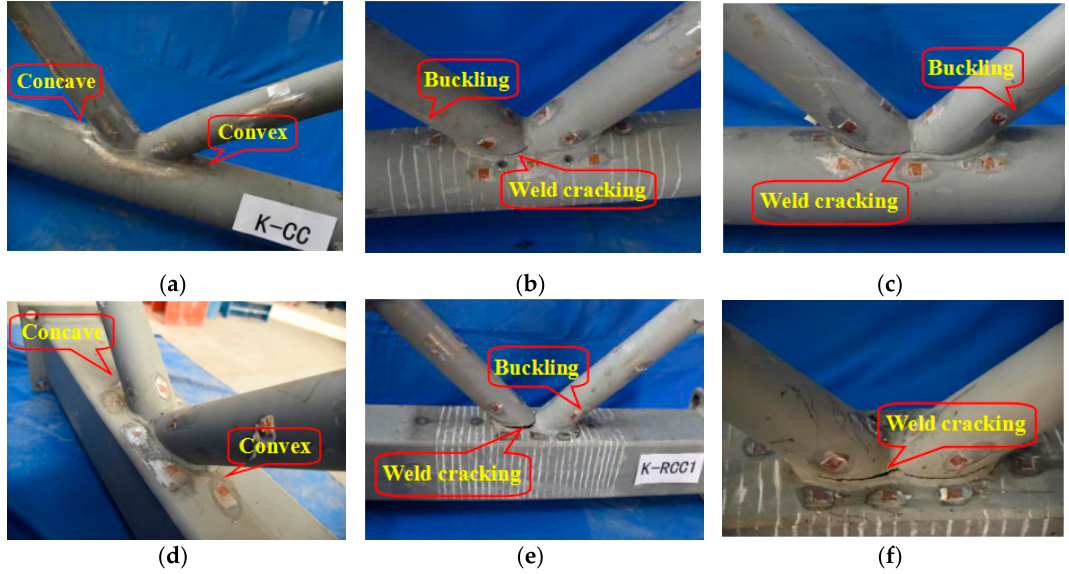
Figure 6. Failure characteristics of the joints. ( a ) K-CC; ( b ) K-CCC1; ( c ) K-CCC2; ( d ) K-RC; ( e ) K-RCC1; ( f ) K-RCC2.